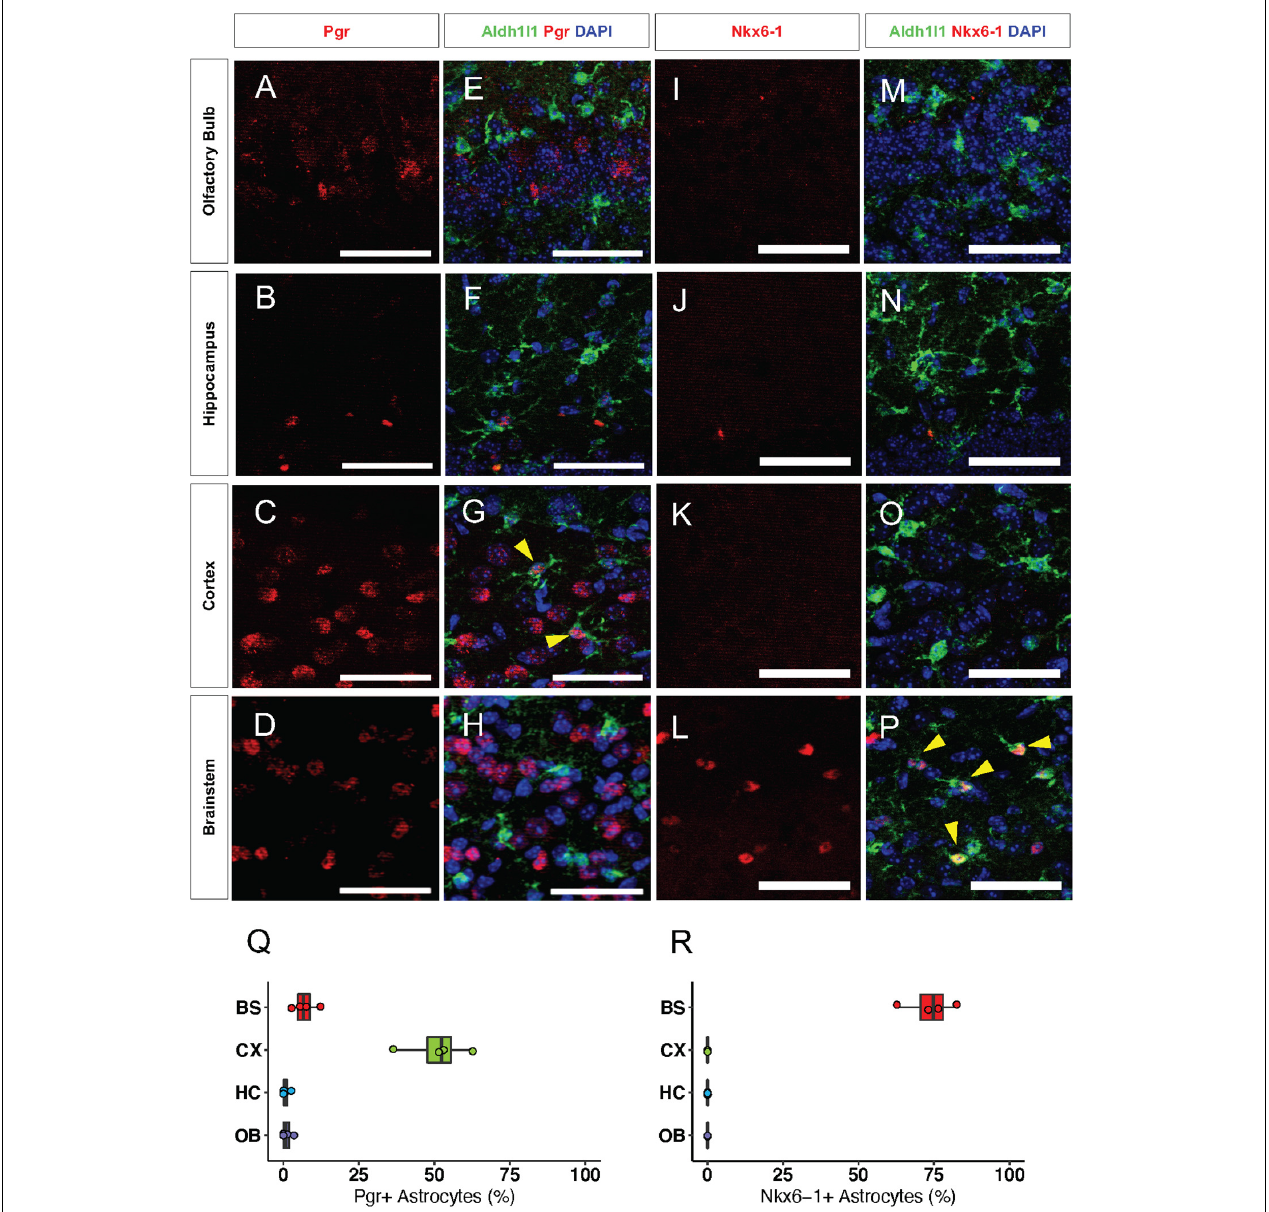
FIGURE 5 | Transcription factors are regionally specific in vivo . (A–H) Representative images of Immunofluorescence staining of Pgr (red) in the (A) OB, (B) HC, (C) CX, and (D) BS. (I–P) Antibody staining of Nkx6-1 (red) in the (I) OB, (J) HC, (K) CX, and (L) BS. (E–H) and (M–P) are the same panels as in (A–D) and (I–L) , respectively, but include Aldh1l1-eGFP expression (green). Yellow arrows indicate double positive cells. (Q–R) Quantification of immunofluorescence staining. (Q) Pgr and (R) Nkx6-1. n = 4 Scale bar = 50 µ m.